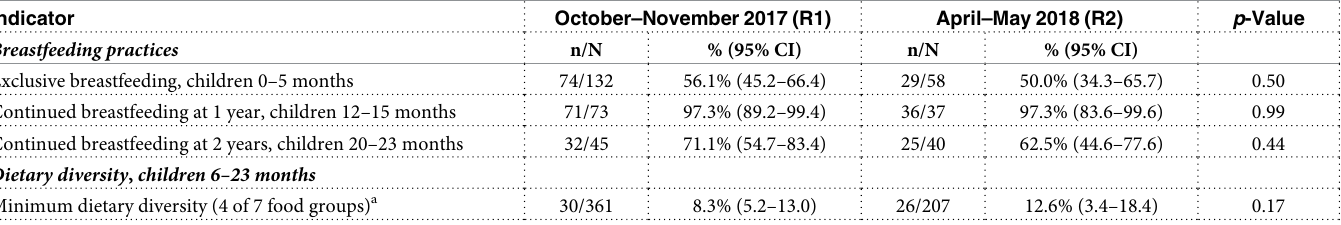
Table 4. Breastfeeding practices and dietary diversity among Rohingya children 6–23 months of age in makeshift and informal settlements—Bangladesh, 2017– 2018.